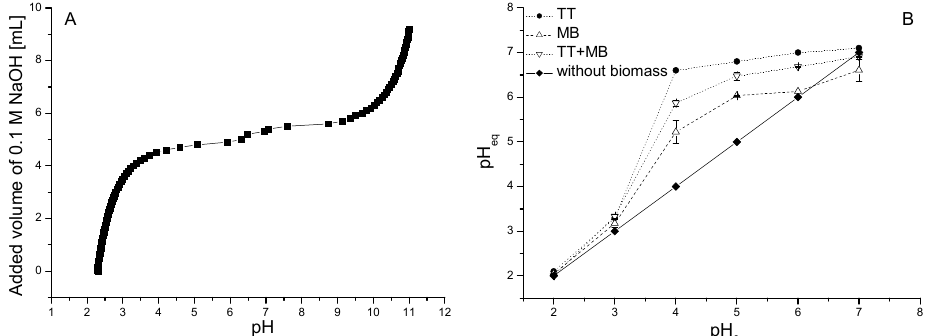
Figure 3. Potentiometric titration curve for dried biomass of freshwater moss V. dubyana (3.0 g/L) obtained by gradual addition of titrant 0.1 M NaOH at background electrolyte 0.1 M NaCl and reaction temperature 25 °C ( A ). The change of initial pH 0 of dye (single and binary) solutions after biosorption and in control experiments in deionized water and without biomass ( B ).